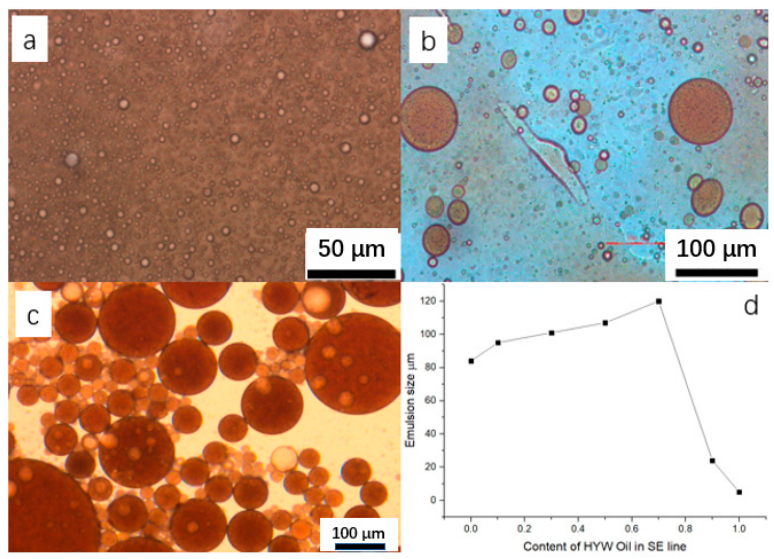
Figure 4. ( a ). The optical photos of HYW emulsion; ( b ). SE emulsion; ( c ). HYW mixed with 70% emulsion; ( d ). Size distribution of different